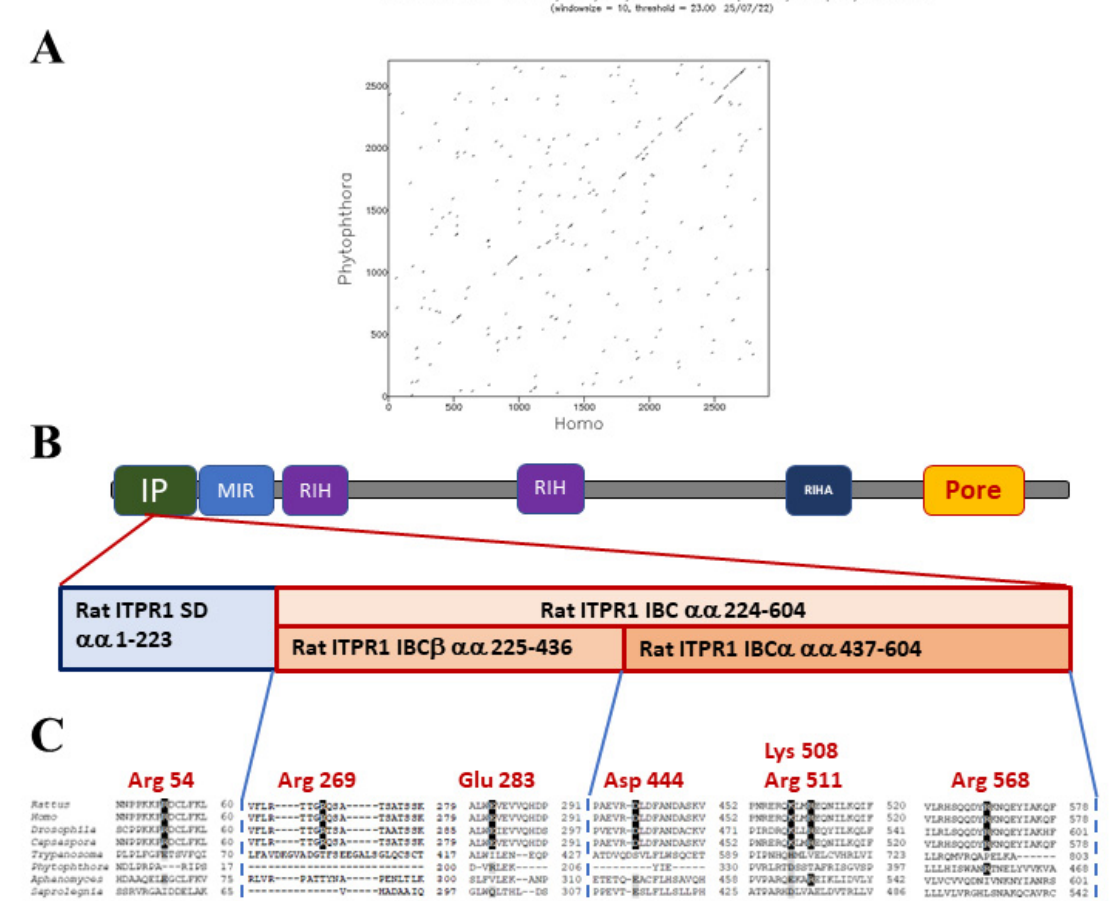
Figure 4. Comparison of IP 3 R proteins from mammals with that from P. infestans . Panel ( A ) shows an amino acid identity plot between IP 3 Rs from H. sapiens (ITPR1) with that from P. infestans . Note the limited identity between the proteins, apart from at the C-terminal channel domain [19]. Panel ( B ) displays the key protein domains (IP: IP 3 -binding domain; MIR: mannosyltransferase, IP 3 R and RyR domain; RIH: RyR and IP 3 R homology domain; RIHA: RIH-associated domain; Pore) within a mammalian IP 3 R ( Rattus norvegicus ITPR1) and expanded view of the IP domain. This includes the suppressor domain (SD) and the β - and α -segments of the IP 3 binding core (IBC). Panel ( C ) represents a multiple sequence alignment of candidate IP domain from the IP 3 Rs of several eukaryotic species: Rattus norvegicus ITPR1, Homo sapiens ITPR1, Drosophila melanogaster ITPR, Capsaspora owczarzaki ITPR, Phytophthora infestans ITPR, Aphanomyces astaci ITPR and Saprolegnia parasitica ITPR. Note the lack of conservation of residues that are critical for interactions between IP 3 and mammalian IP domains, indicated in red text.